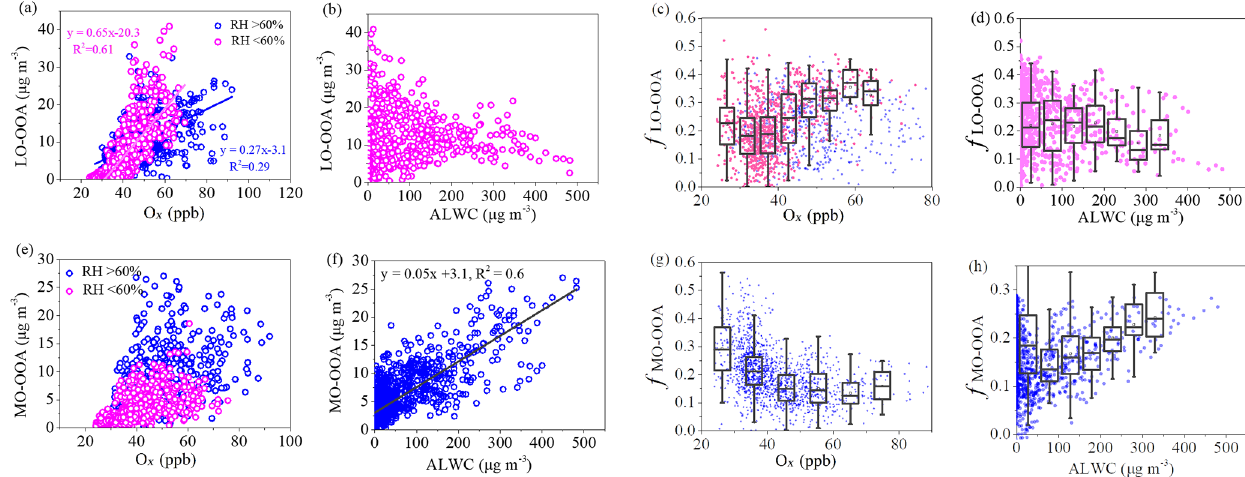
Figure 6. Relationship between LO-OOA or MO-OOA and O x (a, e) and relationship between LO-OOA or MO-OOA and ALWC (b, f) , as well as mass fractions of LO-OOA and MO-OOA as functions of O x (c, g) and ALWC (d, h) in winter.